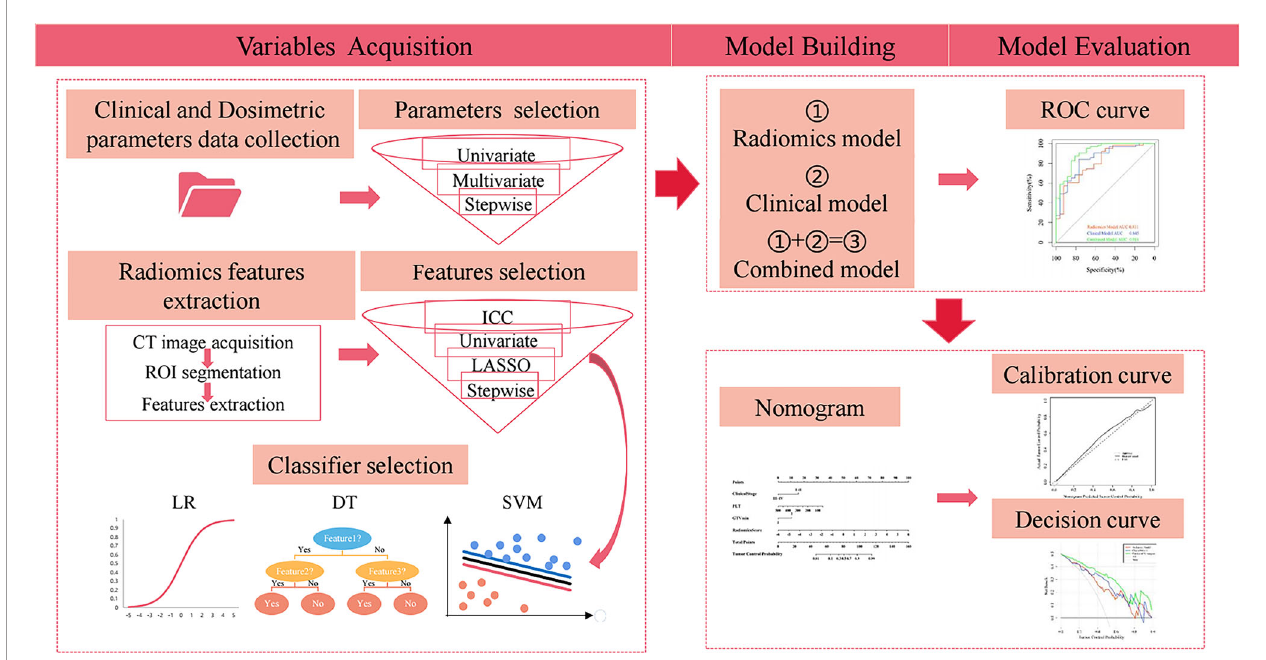
FIGURE 1 | Work fl ow of the study. ROI, region of interest; ICC, intraclass correlation coef fi cient; LASSO, least absolute shrinkage and selection operator; LR, logistic regression; DT, decision tree; SVM, support vector machine. ROC, receiver operating